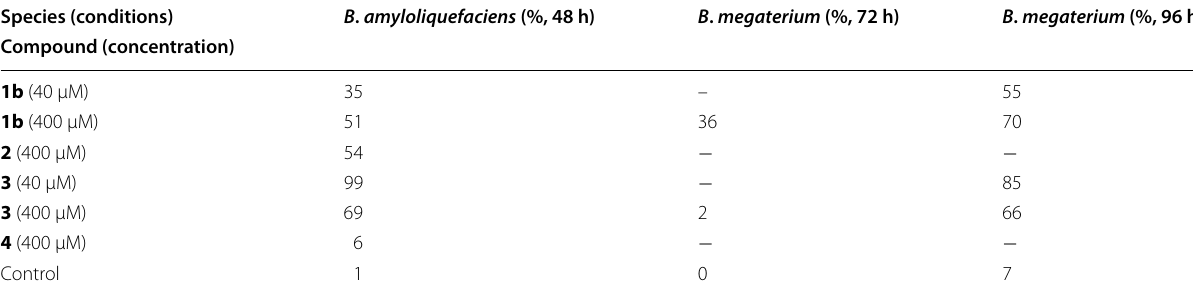
Sporulation frequency (%) is calculated by counting spores and vegetative cells in randomly selected different views. ( and classified into spores and vegetative cells. For 1b and 3 , sporulation assays were repeated trice to confirm their reproducible sporulation inducing activities